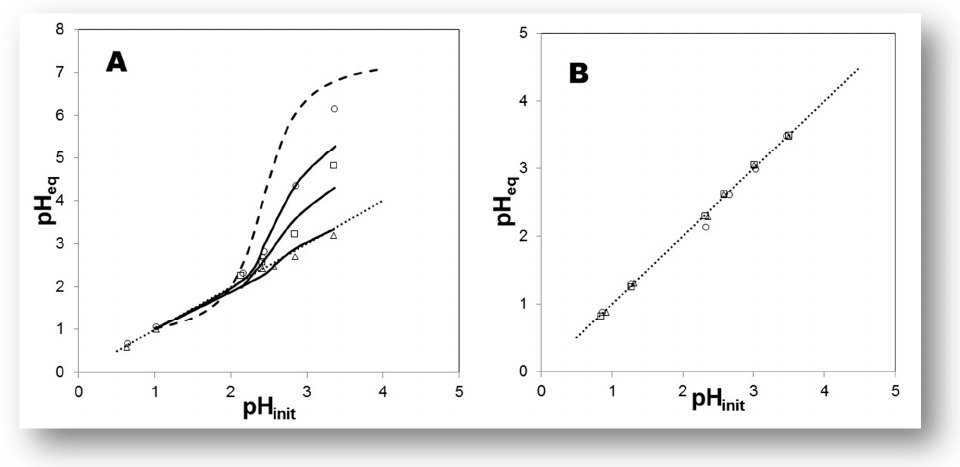
Figure 12. ( A ) Effect of increasing concentrations of HTTA dissolved in [C 1 C 4 im + ][Tf 2 N − ] on the H + concentration at equilibrium. ○ : [HTTA] = 7 × 10 − 3 mol dm − 3 ; □ : [HTTA] = 1.5 × 10 − 2 mol dm − 3 ; Δ : [HTTA] = 3 × 10 − 2 mol dm − 3 . Dotted line: y = x. Dashed line: in the absence of ligand. ( B ) Effect of increasing concentrations of HTTA dissolved in [C 1 C 10 im + ][Tf 2 N − ] on the H + concentration at equi ‐ librium. ○ : [HTTA] = 7 × 10 − 3 mol dm − 3 ; □ : [HTTA] = 1.5 × 10 − 2 mol dm − 3 ; Δ : [HTTA] = 3 × 10 − 2 mol dm − 3 . Dotted line: y = x. Adaptation from Ref. [163] with permission.